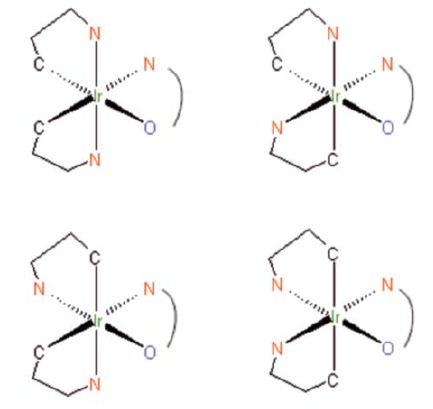
Figure 5. Chemical structures of the (iridium (III) bis[(4,6-fluorophenyl)-pyridinato-N,C 2, ]picolinate)